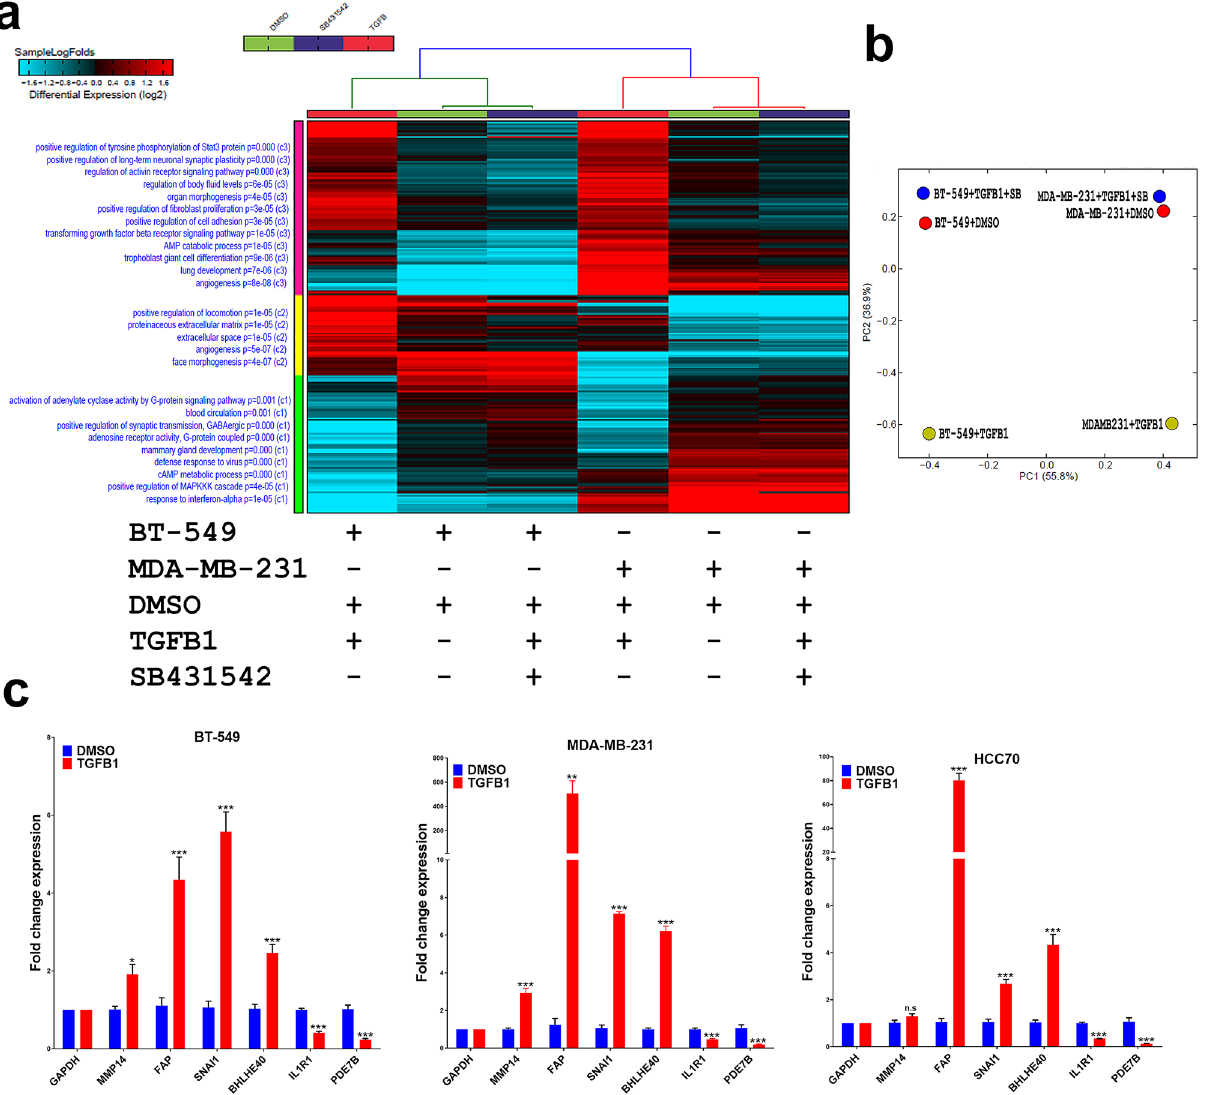
Figure 1. ( a ) Heatmap depicting changes in protein coding gene expression in BT-549 and MDA-MB-231 under different experimental conditions. Enriched gene ontology (GO) associations/pathways are indicated on the y axis. ( b ) Principal component analysis (PCA) for the mRNA transcriptome of BT-549 and MDA-MB-231 under different experimental conditions. ( c ) The expression of selected number of differentially expressed genes was validated using qRT-PCR in BT-549, MDA-MB-231, and HCC70 TNBC models. Data are presented as mean ± SEM (n = 6). * P < 0.05; ** P < 0.005; *** P < 0.0005, n.s. not tion, which also were reversed by concurrent treatment with SB431542 in both TNBC models. Venn diagram depicting the overlap in up and downregulated lncRNAs in both TNBC models identified 41 commonly upregu- lated (FC ≥ 2.0) and 22 downregulated (FC ≤ 2.0) lncRNAs (Fig. 4a,b). Illustration of the differentially expressed lncRNAs in BT-549 and MDA-MB-231 TNBC models is shown as heatmap (Fig. 4c, supplementary table 3). Correlation between lncRNA expression and TGFβ signaling in a large cohort of TNBC patients.